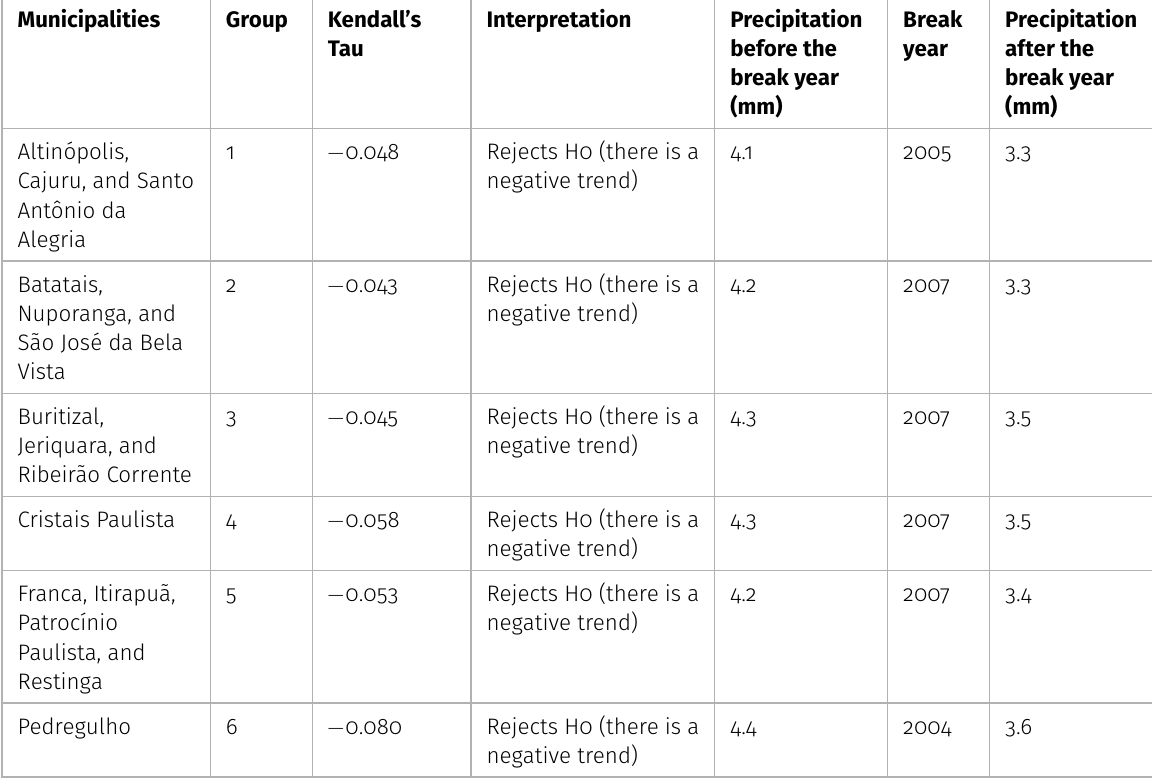
Table III. Mann-Kendall test and Pettitt test values for precipitation. Municipalities Group Kendall’s